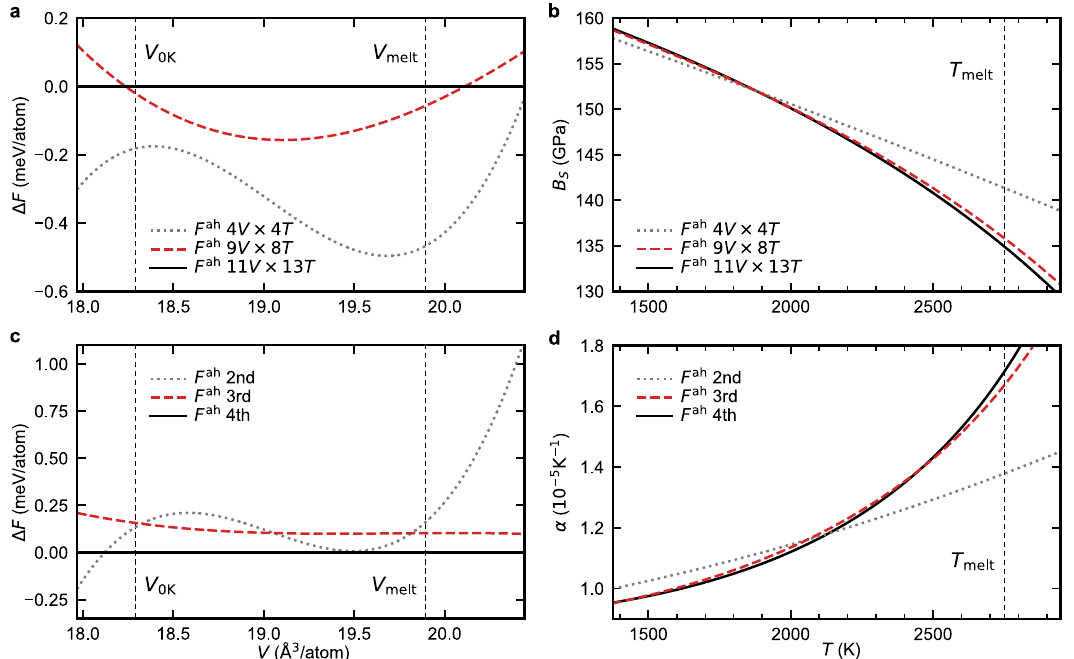
Fig. 4 Convergence of thermodynamic properties. a Anharmonic free energy as a function of volume for Nb at T melt calculated by using different grid densities. The free energy is plotted with respect to the values calculated using the largest grid (11 V × 13 T ). b The corresponding adiabatic bulk modulus for the three grids. c Anharmonic free energy for Nb at T melt calculated using a 11 V × 13 T grid but parametrized with polynomials of a different order. The free energy is plotted with respect to the values calculated using the 4th-order parametrization. d Corresponding thermal expansion coef fi cient for the three